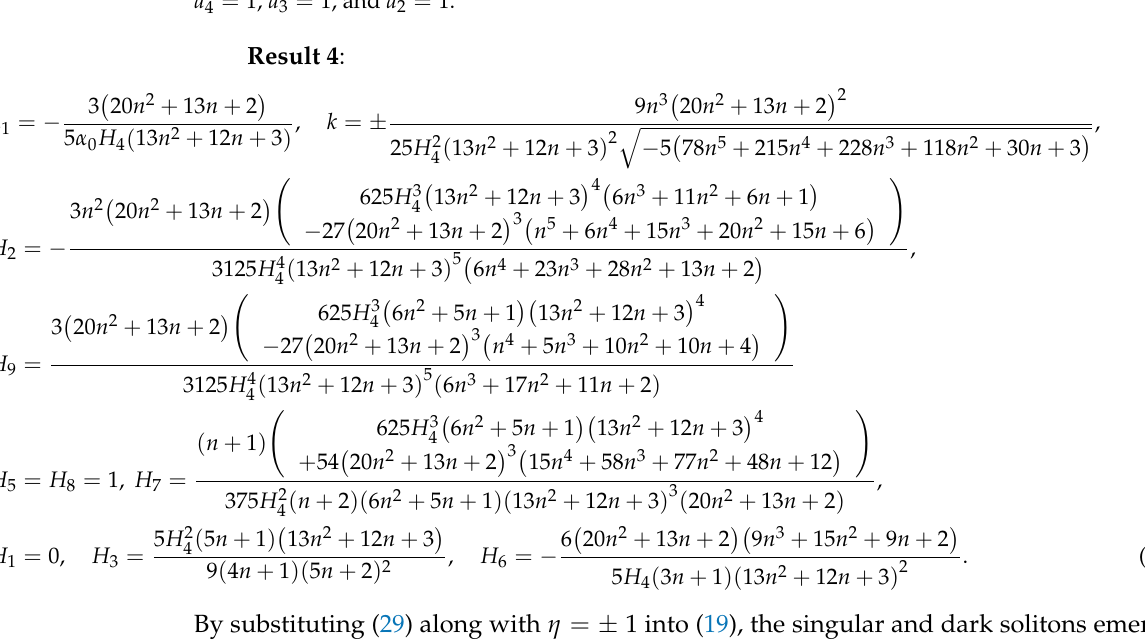
Figure 3. The amplitudes of a dark HD optical soliton (28), with α 0 = 1, b 4 = − 1, a 6 = 1, κ = 1, a 4 = 1, a 3 = 1, and a 2 =